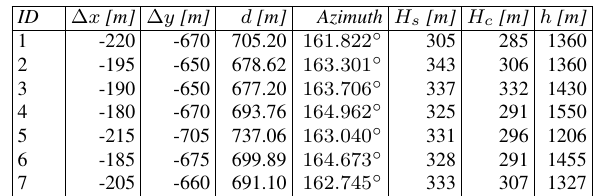
Table 5. Measured cloud-shadow distances, azimuth angles and heights of the ground at shadow position ( H s ) and cloud corner ( H c ) and cloud height above ground from the processing h